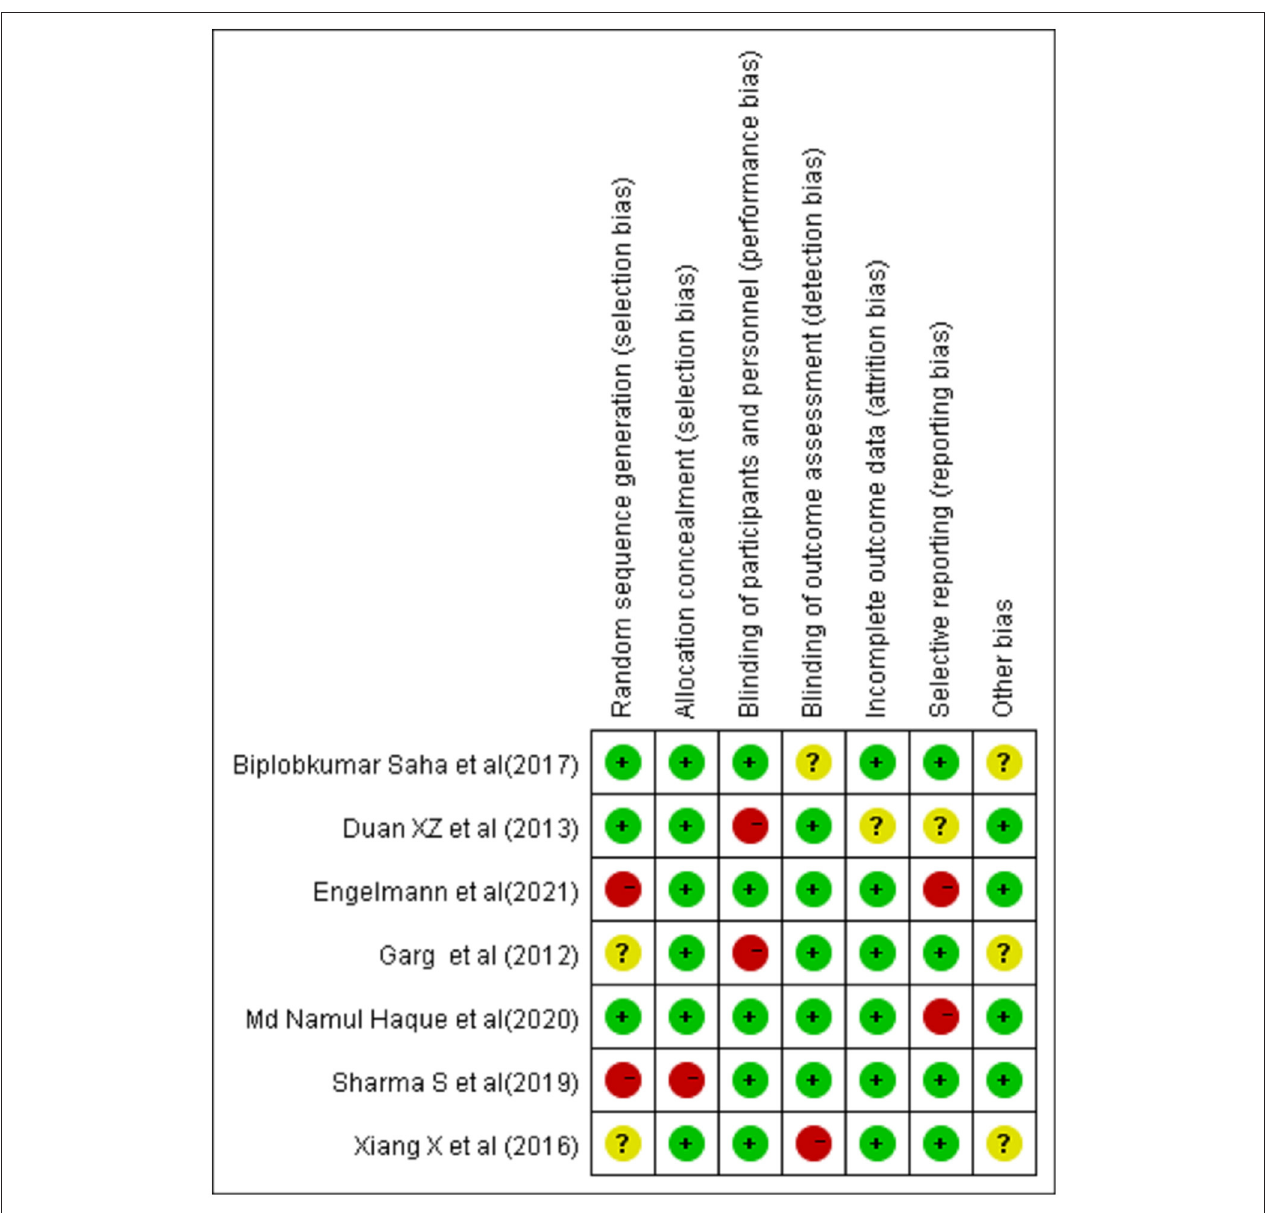
FIGURE 2 | Assessment of risk of